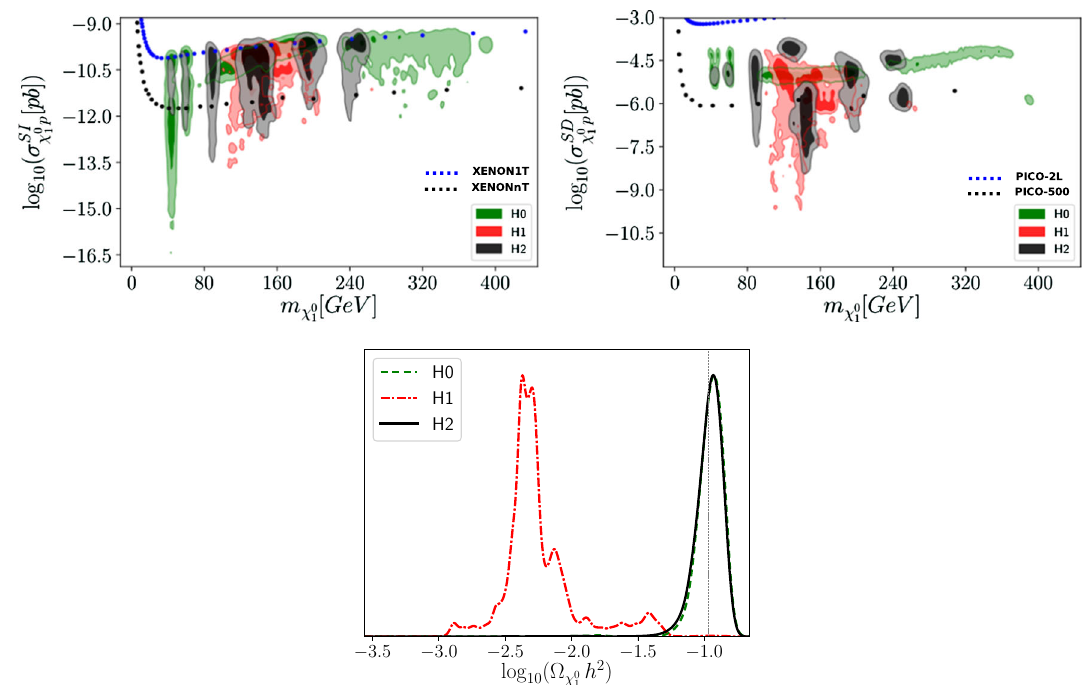
Fig. 4 Marginalised two-dimensional posterior distributions for the neutralino LSP mass versus its spin-independent (1st-row left) and spin-dependent (1st-row right) scattering cross-section with proton. The green ( H 0), red ( H 1) and black ( H 2) regions represent H 1 , H 1 and H 2 scenarios respectively. Inner and outer contours respectively enclose 68% and 98% Bayesian credibility regions of the posteriors. The blue/dotted contour lines on the left- and right-hand side plots show respectively the XENON1T [121] and PICO-2L [124] which rep- resents the most constraining of the CDM direct detection limits used.